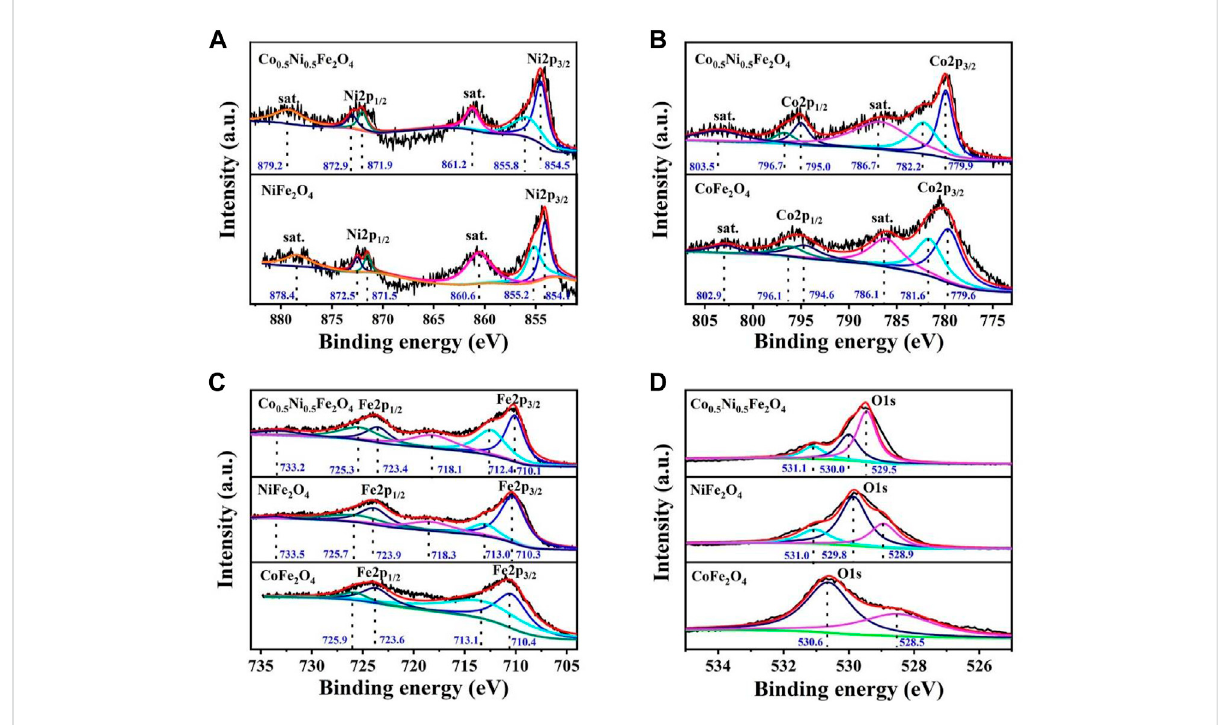
FIGURE 3 XPS spectra of the Co 0.5 Ni 0.5 Fe 2 O 4 , NiFe 2 O 4 and CoFe 2 O 4 spheres (A) Ni 2p; (B) Co. 2p (C) Fe 2p; and (D)